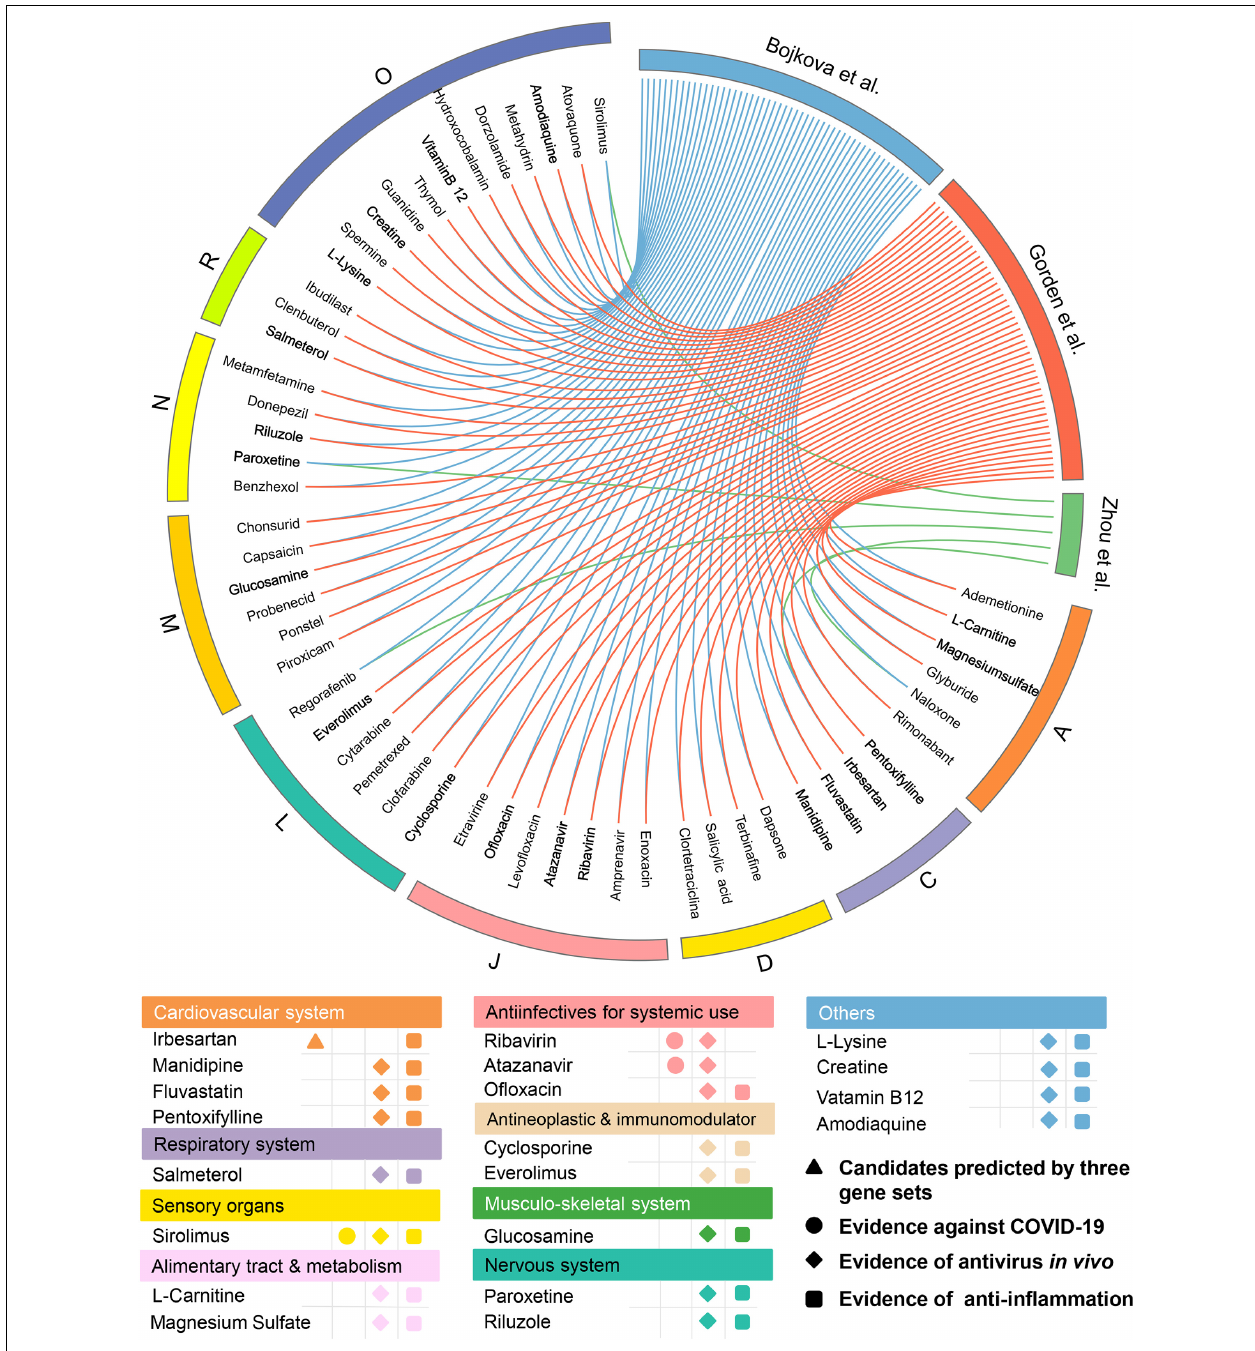
FIGURE 5 | Network-based in silico prediction of approved drugs against COVID-19. Circos plot exhibiting 53 potential drug candidates identified by network proximity analysis. The full version exhibiting all the predicted approved drugs ( p < 0.05) is provided in Supplementary Table 3 . All drugs are grouped by their first-level Anatomical Therapeutic Chemical Classification (ATC) codes. Twenty best drug candidates were selected based on multiple studies from antivirus in vivo and anti-inflammation. Note: A: alimentary tract and metabolism; C: cardiovascular system; D: dermatologicals; J: anti-infectives for systemic use; L: antineoplastic and immunomodulating agents; M: musculo-skeletal system; N: nervous system; R: respiratory system; and O: others.